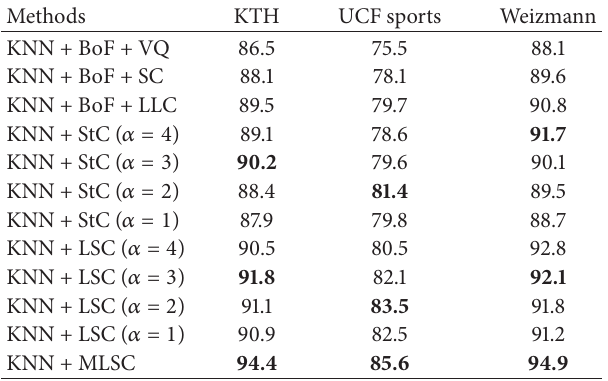
Table 1: The average accuracy of BoF together with VQ, SC, LLC and our methods on KTH, Weizmann, UCF sports datasets (unit: %).